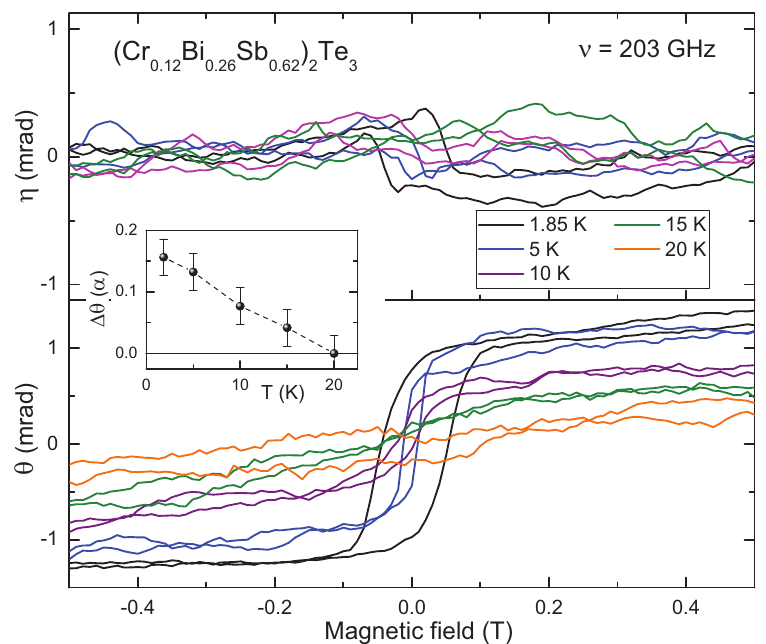
Figure 4. Complex polarization rotation angle θ + i η in (Cr 0.12 Bi 0.26 Sb 0.62 ) 2 Te 3 at ν = 203GHz and at different temperatures. Bottom panel: Faraday rotation angle θ , top panel: ellipticity η . The inset shows the absolute values of the step of the rotation angle in the units of the fine structure constant at zero magnetic field and as a function of